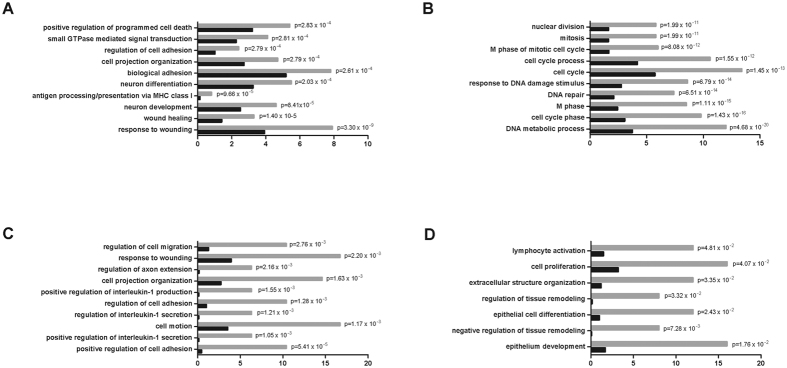
HOPX regulates the expression of genes involved in epithelial homeostasis.Gene ontology (GO) analysis of down-regulated (A) and up-regulated (B) genes identified by RNASeq following ectopic expression of HOPX in H376 OSCC cells. Genes with over 1.5 fold change in expression in H376/HOPX cells compared to H376-pIRES were subjected to GO analysis. A similar GO analysis was performed on those genes down-regulated by HOPX in H376 and up-regulated in primary OSCCs (C) and those up-regulated by HOPX in H376 and down-regulated in tumours (D). Genes altered in H376/HOPX were compared with genes whose expression was altered in micro-dissected OSCCs (GSE35261 dataset16).